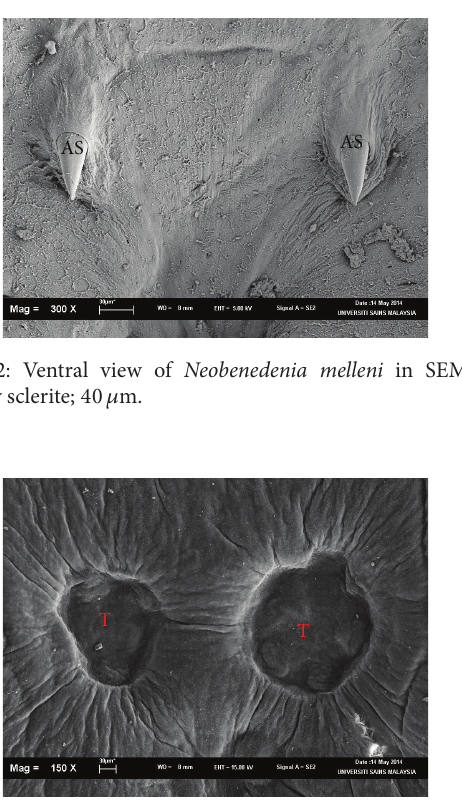
Figure 3: Ventral view of Neobenedenia melleni in SEM; T = testis organs.